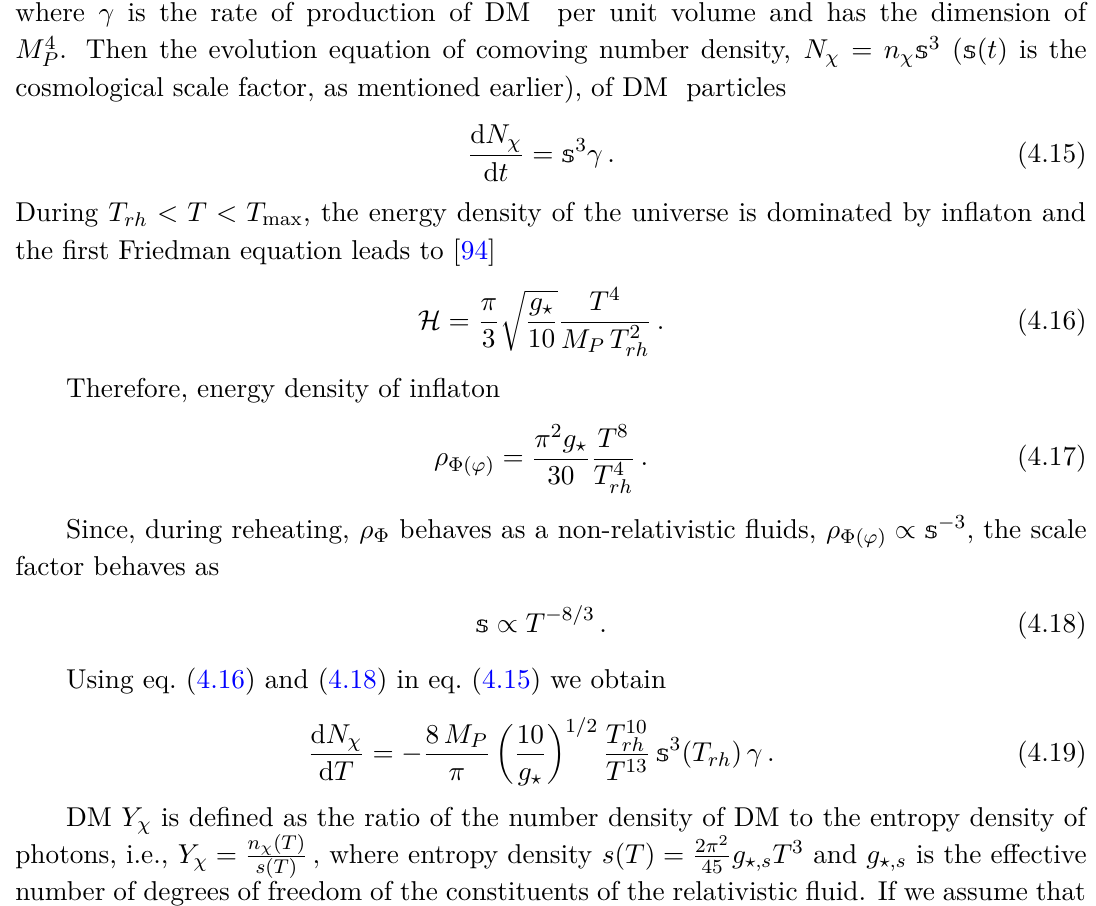
Figure 5. Allowed range (colored region) for T max /T rh : left panel is for the linear term inflation, where right panel is for the sextic term inflation. The green color line is for T T max = 4 MeV. The gray colored region indicates the lower ( T rh (cid:4) 4 MeV) and upper bound on T rh . The upper bound is coming from the stability analysis (see eq. (3.9) and eq.